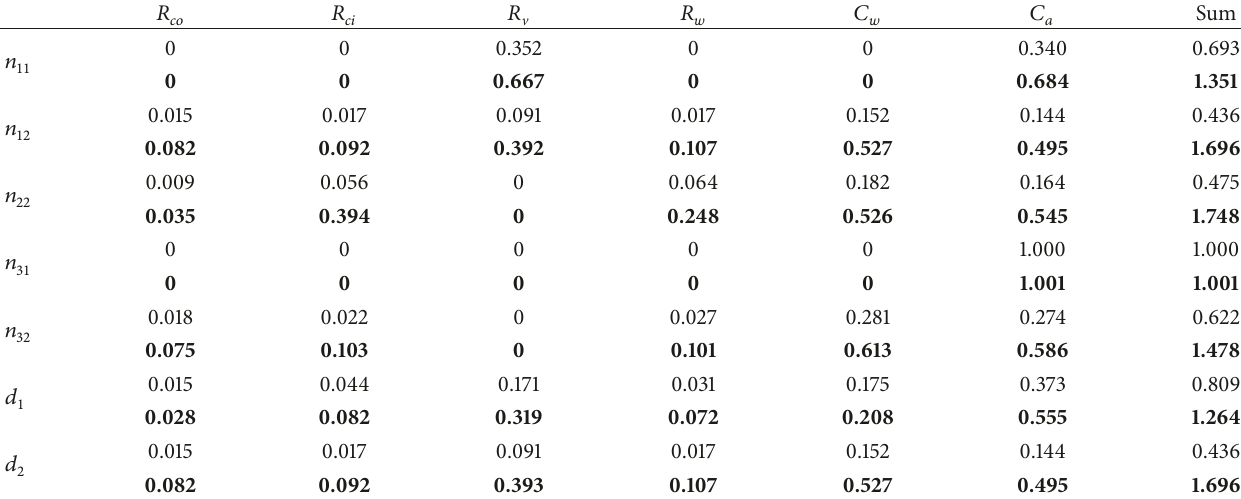
Table 9: First-order and total sensitivity indices, RC to ARX transformation.